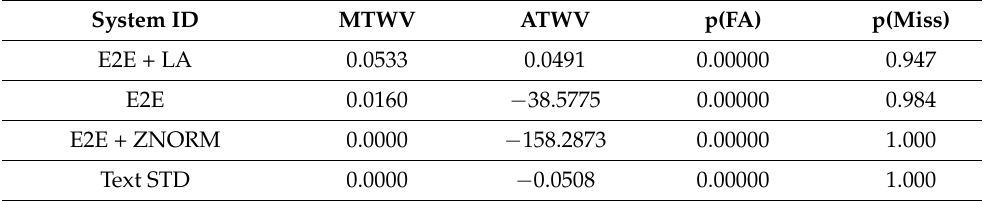
Table 13. System results of the QbE STD task for MAVIR development data.